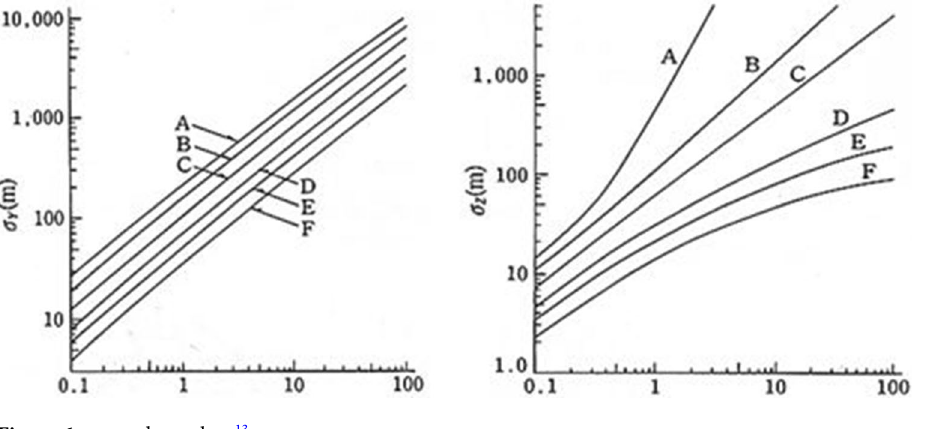
Figure 6. σ y and σ z values 13